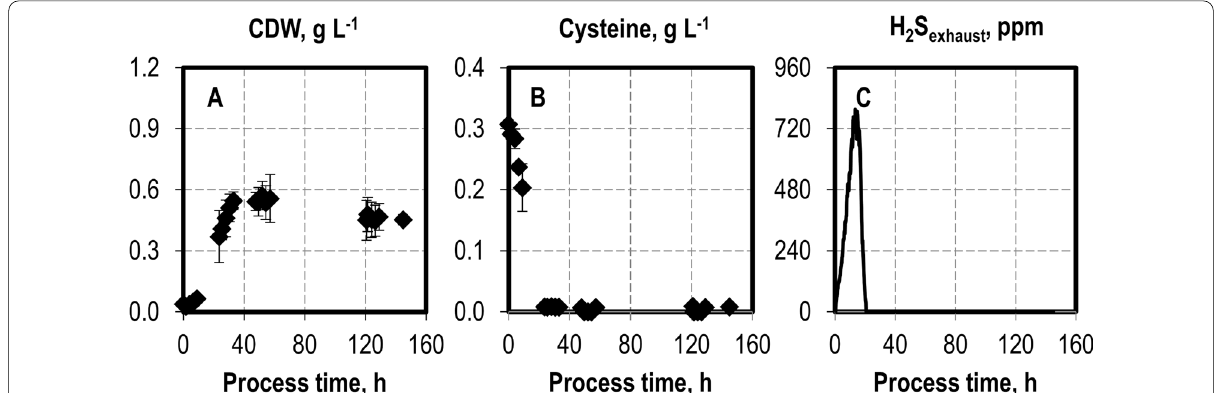
Fig. 3 Sulphur availability in autotrophic batch process with C. ragsdalei in a continuously gassed STR: cell dry weight ( A CDW) concentration, cysteine concentration ( B ), and hydrogen sulfide in exhaust gas ( C ). The batch processes were operated at a working volume of 1 L, volumetric power input of 3.5 W L − 1 , pH 6.0, and a gas flow rate of 5 NL h − 1 with an inlet partial pressure of 0.2 bar H 2 , 0.2 bar CO 2 , and 0.6 bar CO. The batch process was conducted in triplicate;